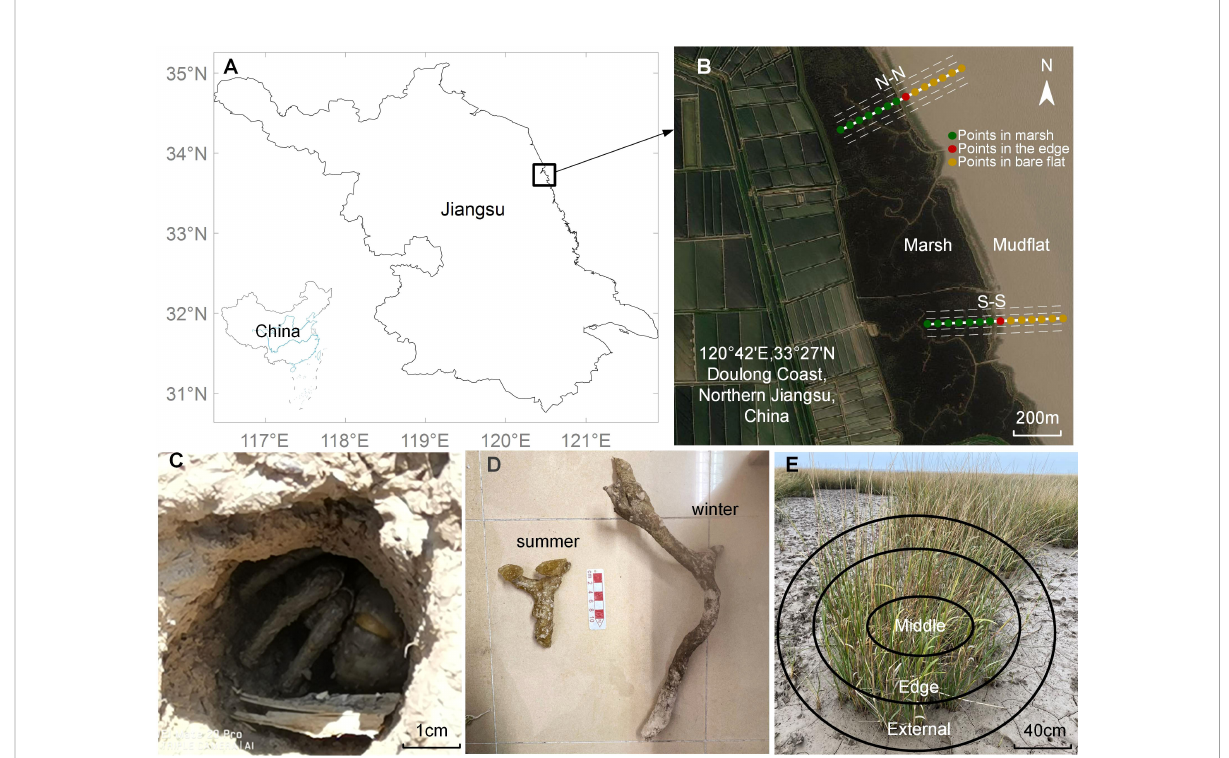
FIGURE 1 (A) Location of the study area; (B) Sampling site and sections arrangement, the solid lines represent the two sampling sites and the dashed lines represent the repeated sampling sections in each site, green points represent the sampling points in the marsh, red points represent the sampling points in the edge, yellow points represent the sampling points in the bare fl at; (C) Photo of Helice tientsinensis and its burrow; (D) Different sizes of burrows in summer and winter; (E) Small-scale zonation of plant